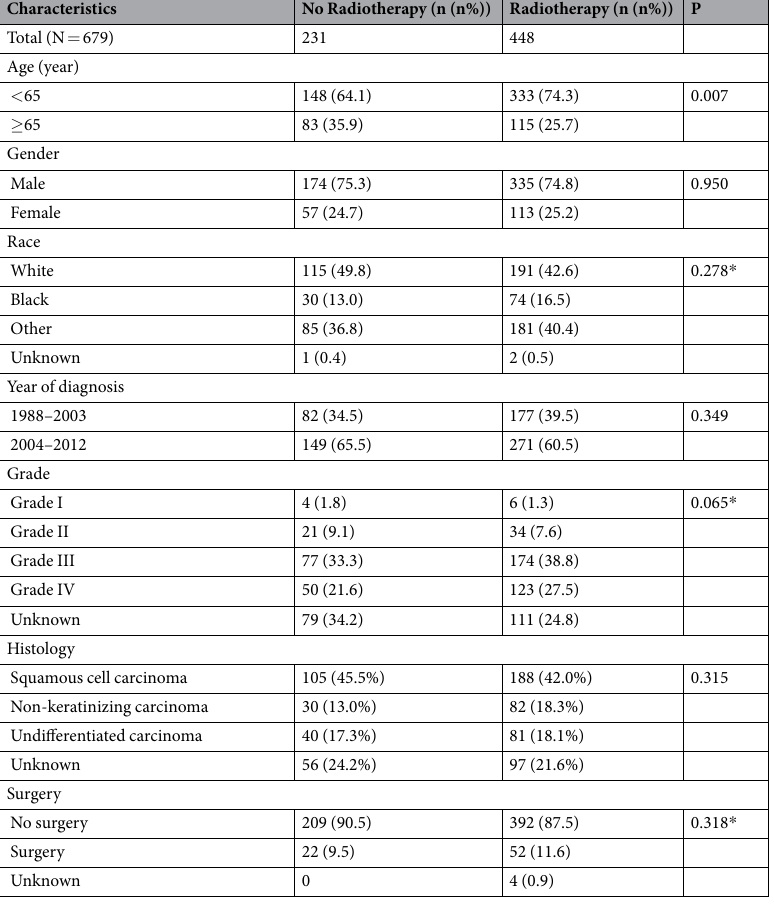
Table 1. Baseline characteristics of the study population. * Fisher’s exact test was